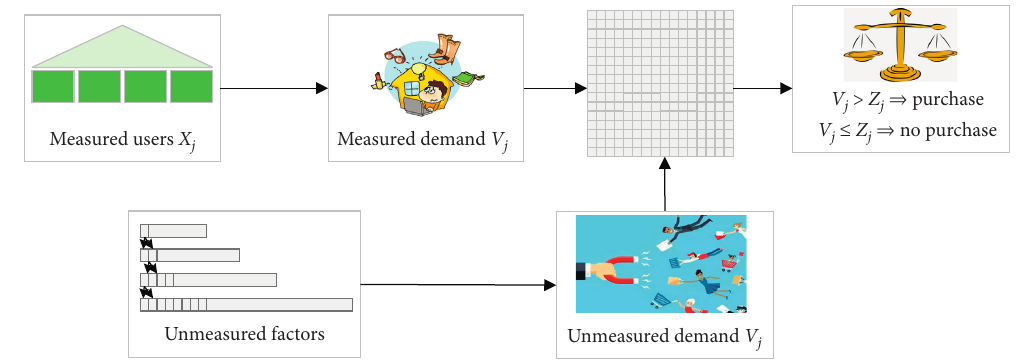
Figure 2: The structure of the NPTB